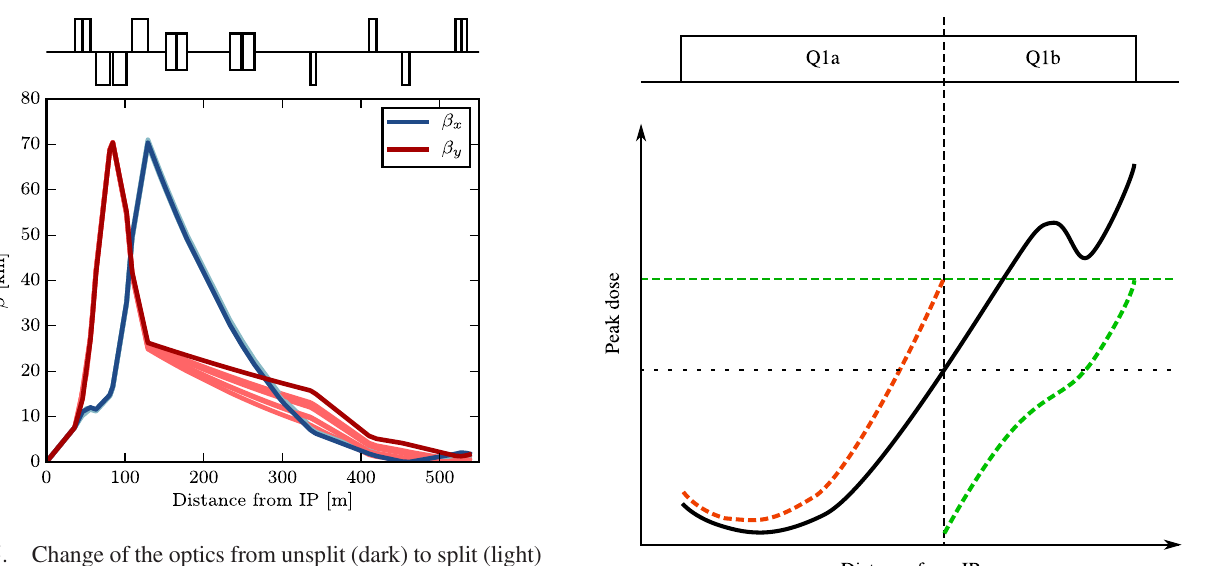
FIG. 15. Change of the optics from unsplit (dark) to split (light) ¼ 1 . 2 and 1.5, each with λ ¼ 0 . 3 ; 1 . 0 ; 3 . 0 . No rematch- Q1 for r g ing was performed.